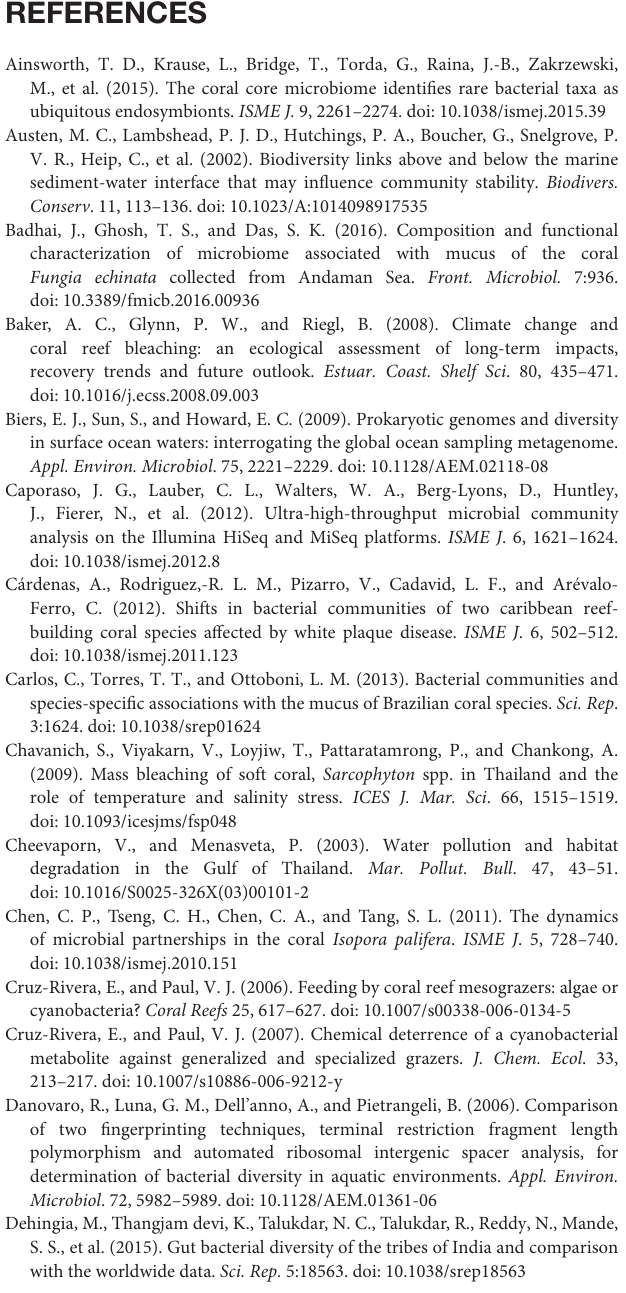
Figure S1 | Estimated taxonomic richness (rarefaction curve) at levels of phylum (A) , class (B) , order (C) , family (D) , and genus (E) of prokaryotic communities. Figure S2 | Percent relative abundance of prokaryotes categorized into bacteria and archaea.